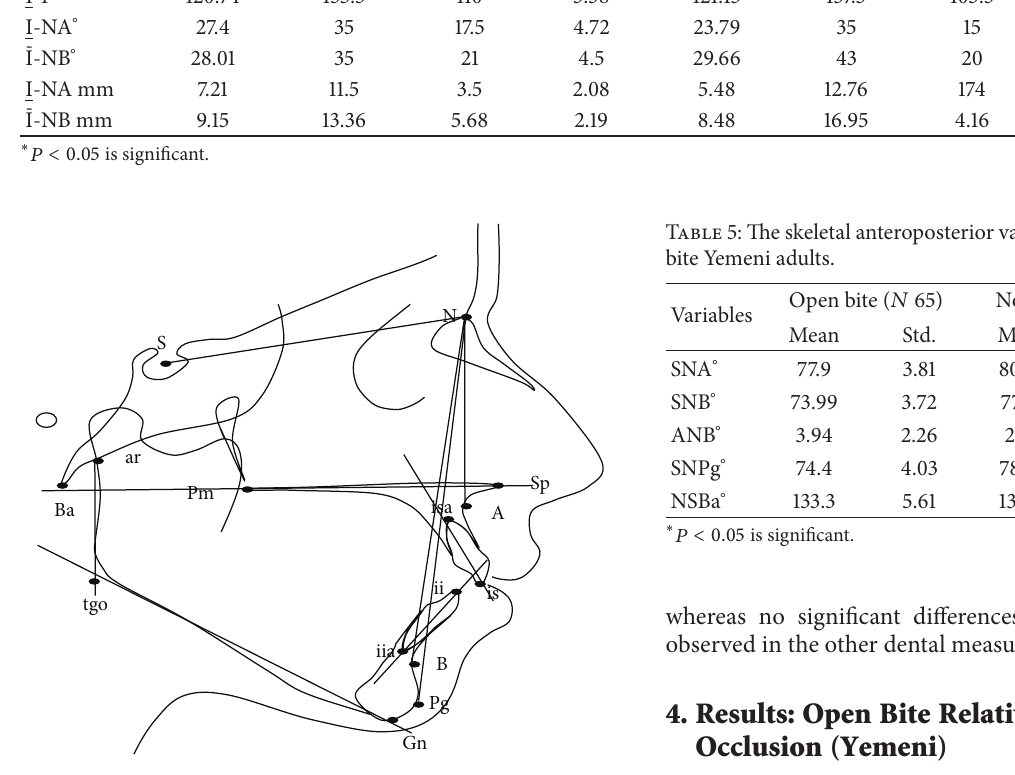
Figure 1: Cephalometric lines and angles.